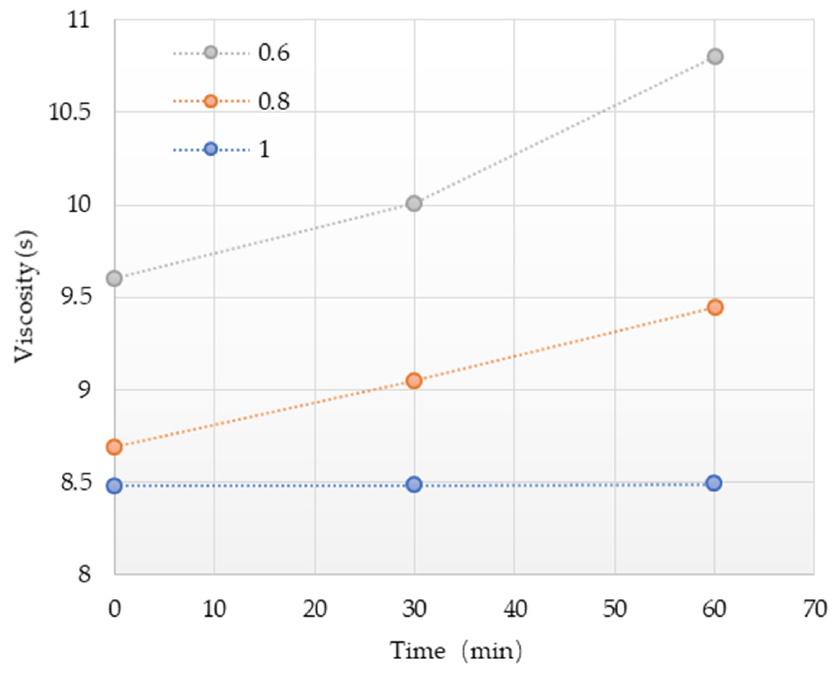
Figure 4. Fluidity test results of different water–cement ratios.